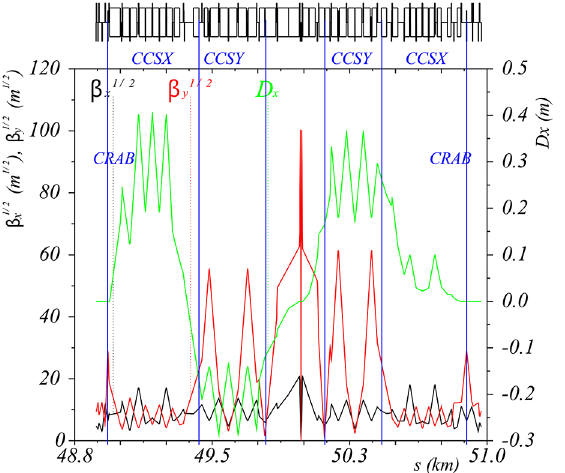
FIG. 12. Optical functions of FCC-ee interaction region variant 2.